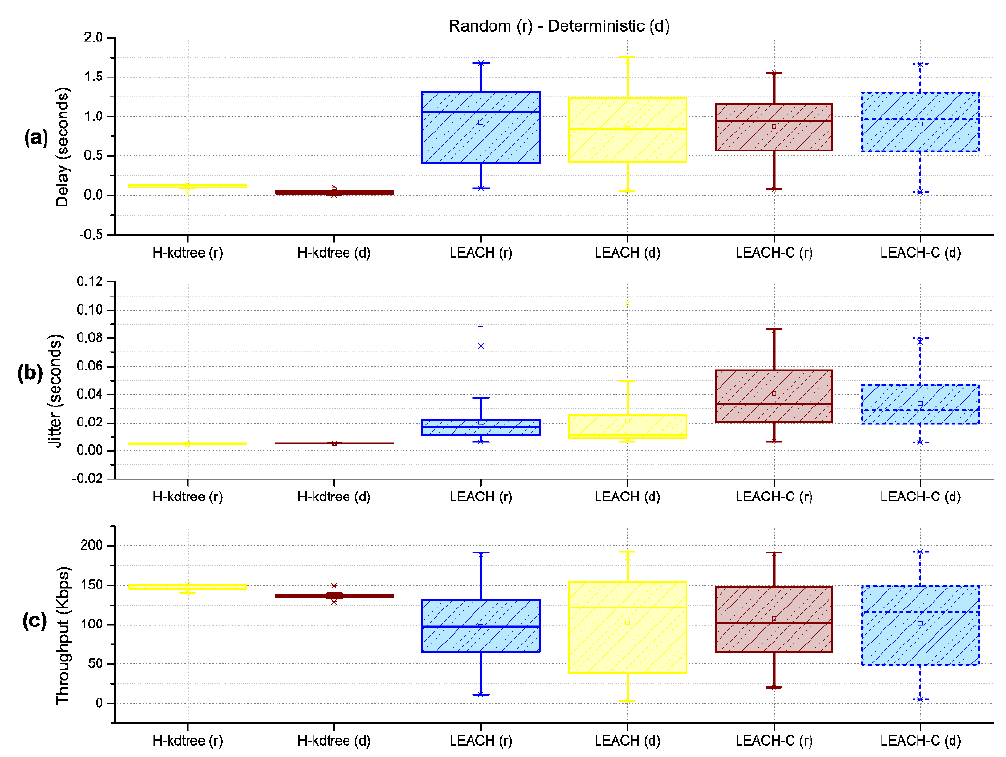
Figure 18. General QoS metrics.